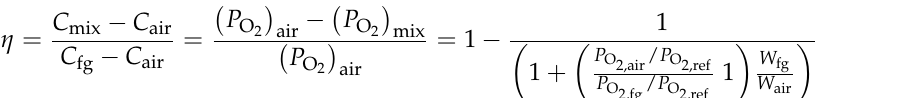
Figure 3. Pressure sensitive paint (PSP) calibration curve.